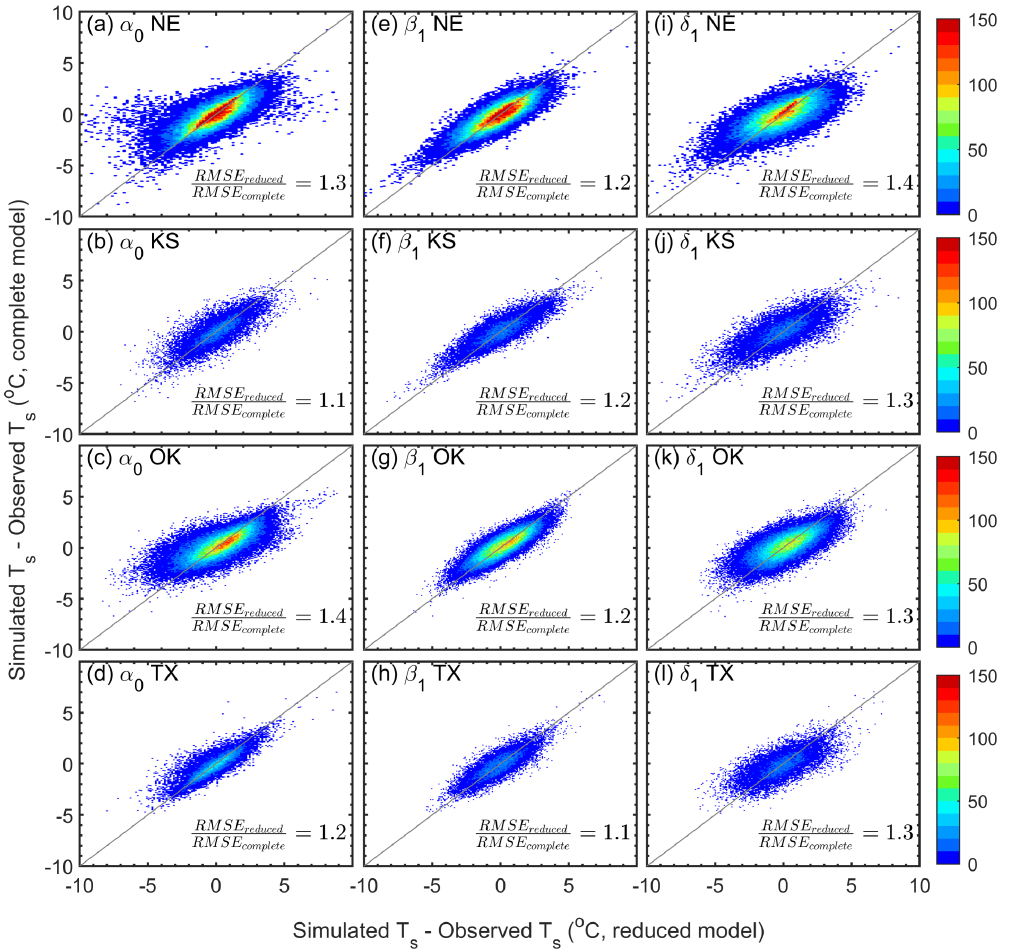
Figure 5. The 1 : 1 plots of absolute mean errors between the complete model and reduced model, where one independent variable term was removed in the improved empirical model (iEM02). Panels (a–d) compare results with vs. without α 0 in Nebraska (NE), Kansas (KS), Oklahoma (OK), and Texas (TX), respectively; panels (e–h) compare results with vs. without β 1 in NE, KS, OK, and TX, respectively; and panels (i–l) compare results with vs. without δ 1 in NE, KS, OK, and TX, respectively. The ratio of the root mean square error (RMSE) shown includes both RMSE values calculated from complete and reduced models, respectively. The color bar indicates the number of observed data